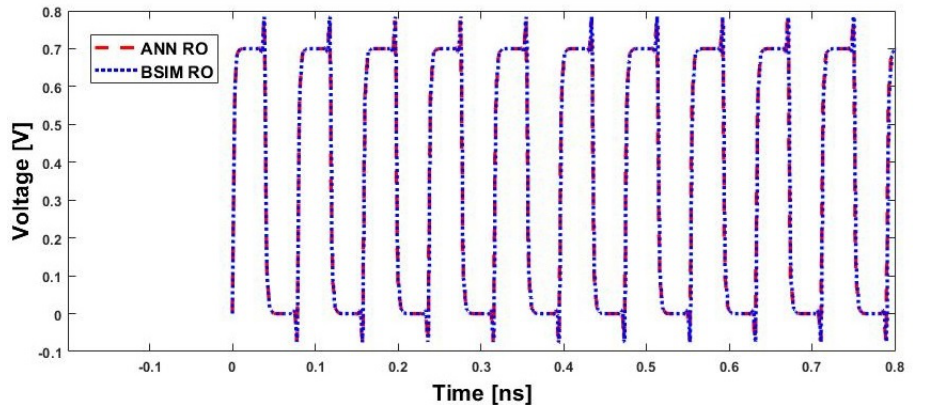
Figure 10. Comparison of the ANN model and the BSIM-CMG model for the 17-stage ring oscillator